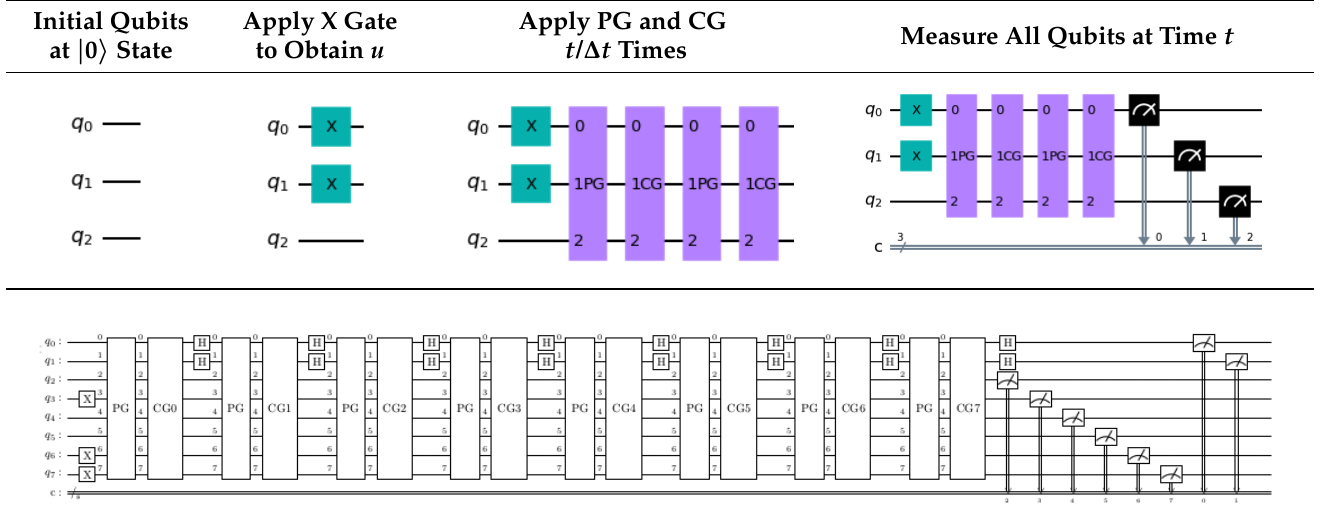
Figure 1. Quantum circuit diagram for u = 200, c = 20, m = 15, σ 2 = 4, t = 8.